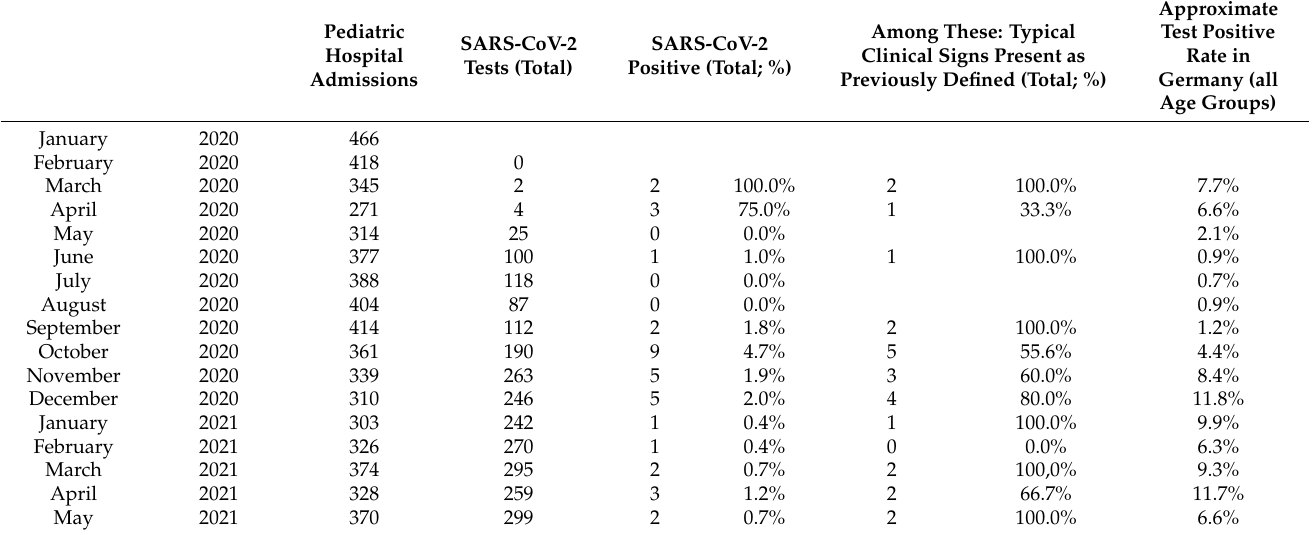
Table 1. Pediatric hospital admissions, SARS-CoV-2 test numbers and results and clinical symptoms compiled together with the approximate test positive rate in Germany (all age groups and test sites, source: